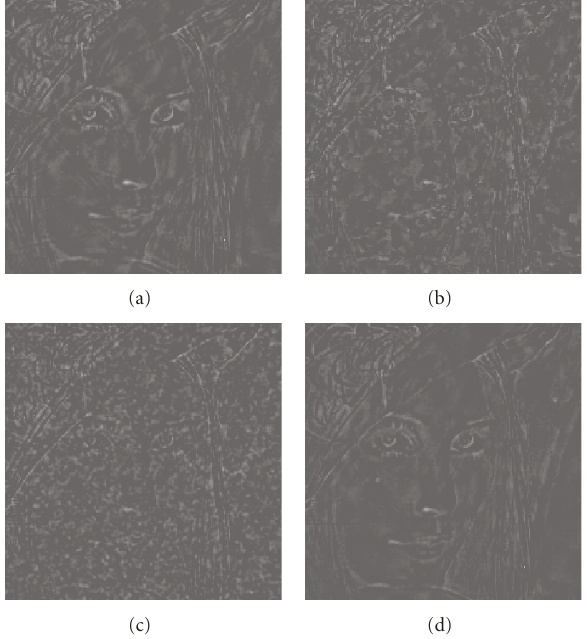
Figure 11: The di ff erence images between the original “Lena” and restored “Lena” images in Figure 10: (a) by the curvelet Shrinkage method; (b) by using the “TV” model; (c) by using the “TVGF” model; (d) by using our proposed